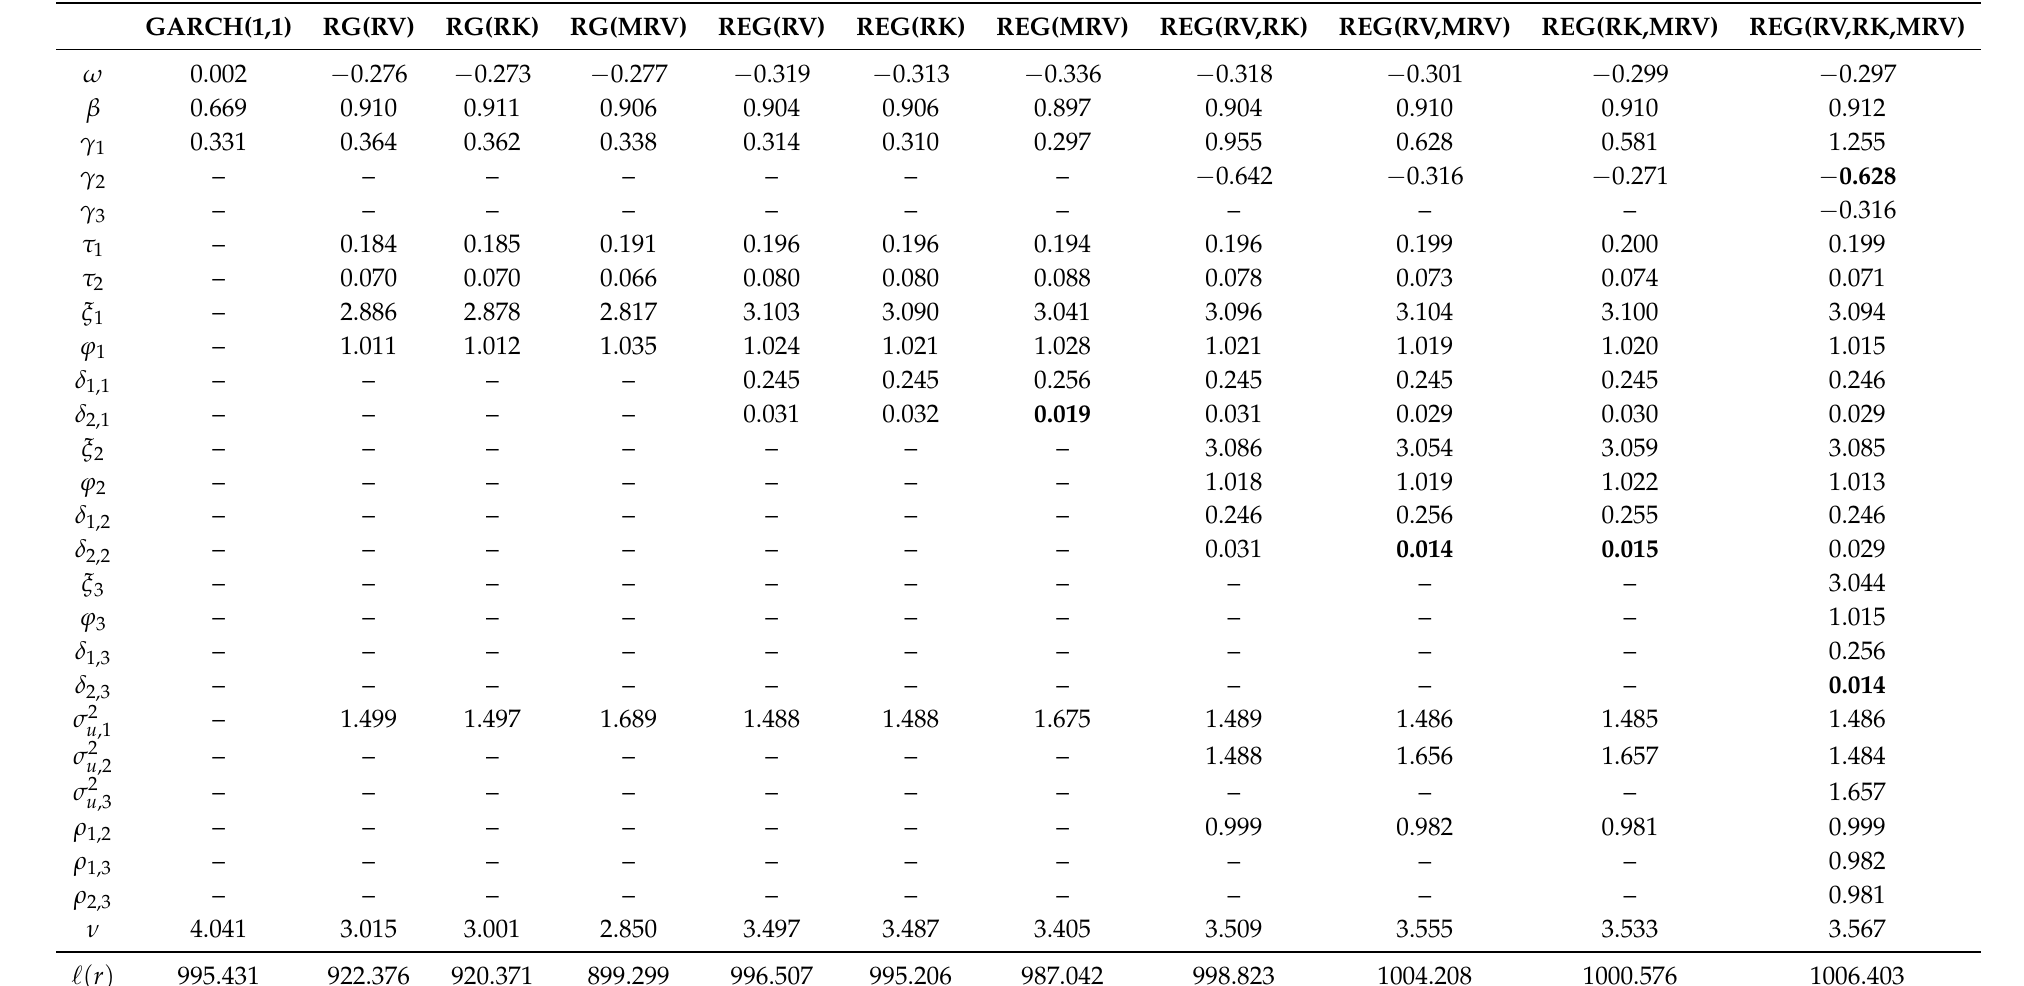
Table 3. QLD in-sample parameter